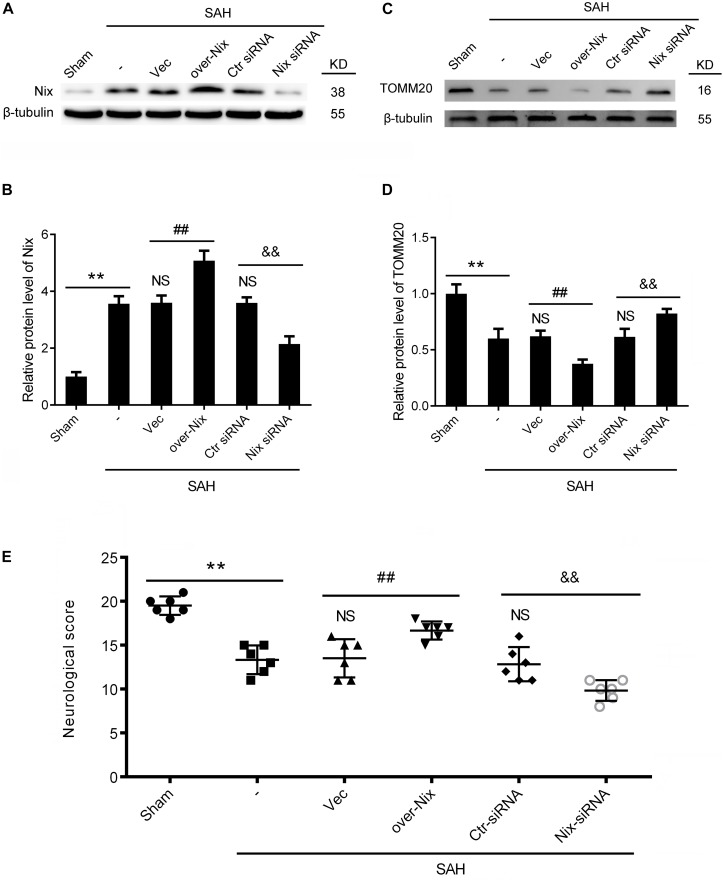
Effects of Nix on EBI at 24 h after SAH. (A–D) Western blot showed the protein levels of Nix and the mitochondrial marker protein, TOMM20, in the Sham, SAH, SAH + Vec, SAH + over-Nix, SAH + Ctr siRNA, and SAH + Nix siRNA groups at 24 h after SAH. Data represent the mean ± SD; **p < 0.01 vs. Sham group; NSp > 0.05 vs. SAH group; ##p < 0.01 vs. SAH + Vec group; &&p < 0.01 vs. SAH + Ctr siRNA group; n = 6. (E) Composite Garcia neuroscore; **p < 0.01 vs. Sham group;NSp > 0.05 vs. SAH group; ##p < 0.01 vs. SAH + Vec group; &&p < 0.01 vs. SAH + Ctr siRNA group; n = 6.